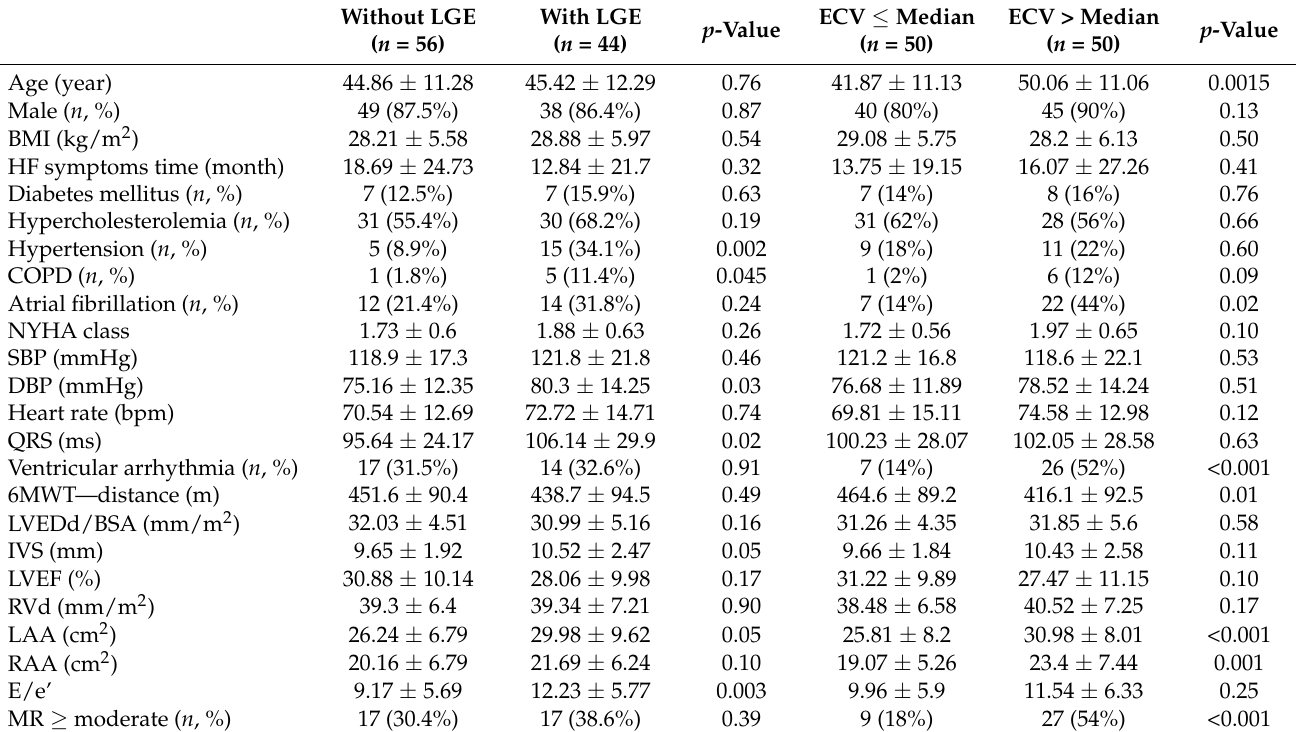
Table 1. Baseline characteristics. Comparison of DCM patients with and without LGE and DCM patients stratified according to median value of